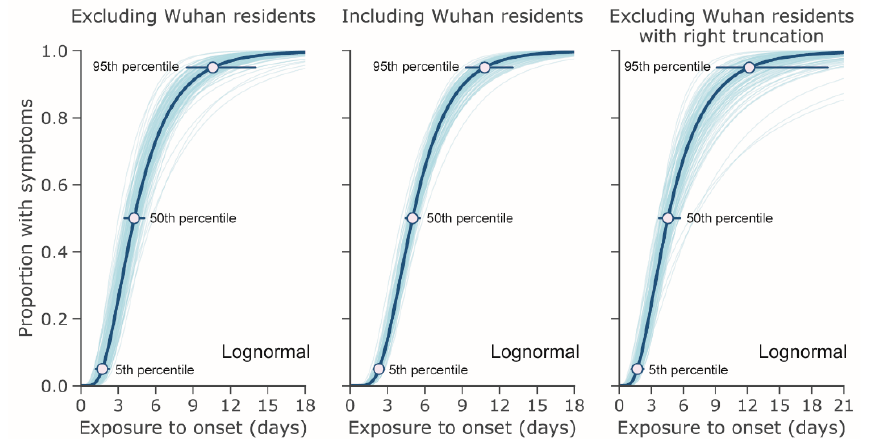
Figure 2. Estimated cumulative distribution for the incubation period of COVID-19 infections from outbreak cases reported through 31 January 2020. The data are from public case reports. Left and center: non-truncated estimates excluding ( n = 52) and including ( n = 158) Wuhan residents. Right: right-truncated estimates excluding Wuhan residents ( n = 52).